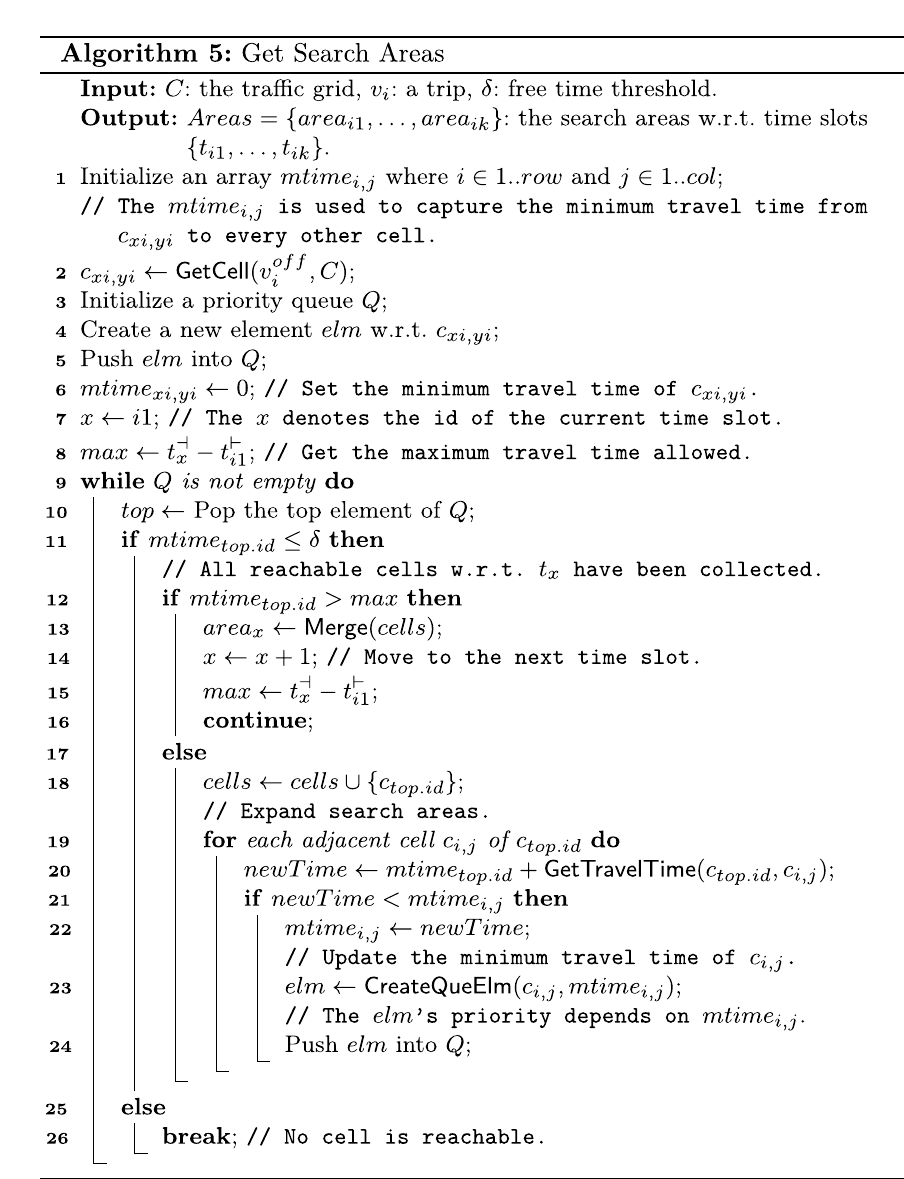
Fig. 11b we obtain three reachable cells. Note that the numbers in this figure indicate the priorities of the